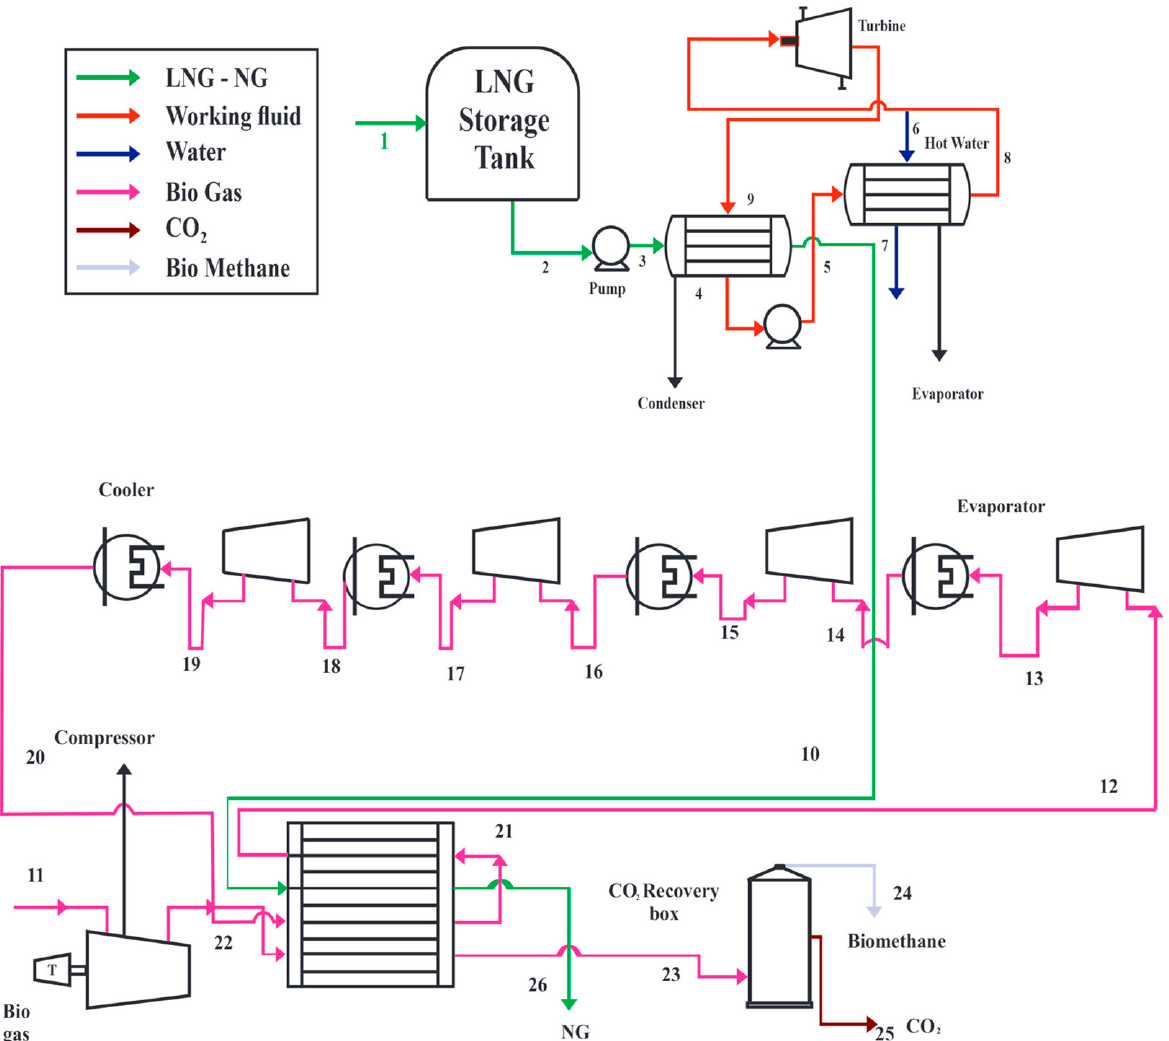
Figure 1. Representation of the novel integrated LNG regasi fi cation process-Organic Rankine Cycle and the ANSU energy system.